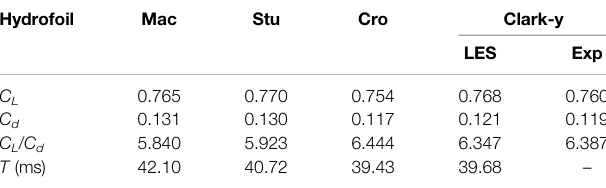
TABLE2| Averagelift – dragcoef fi cientandlift-to-dragratioandcavitationcycle( T ) of each hydrofoil.